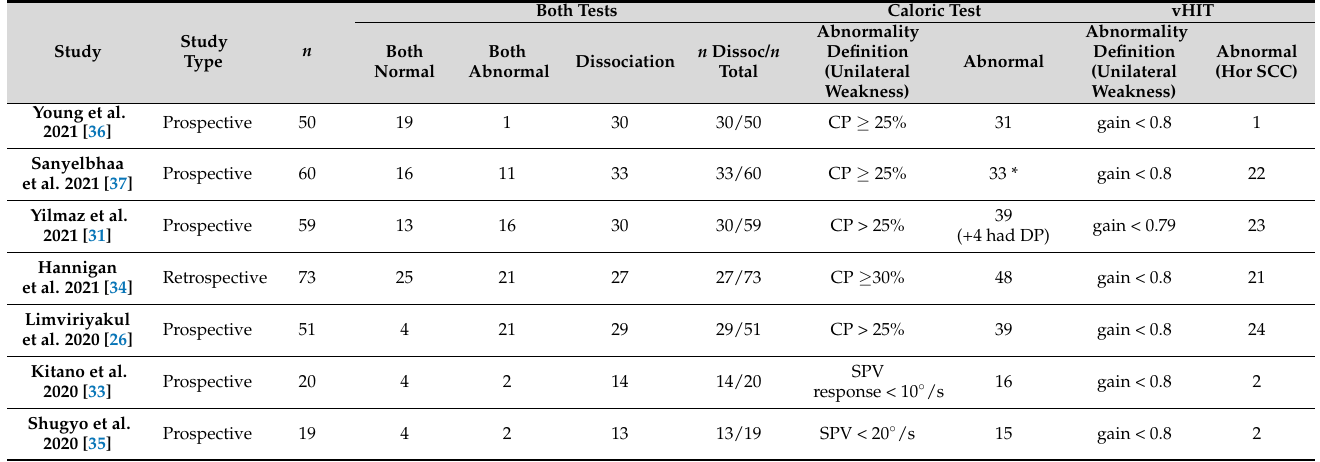
Table 1. M é ni è re’s